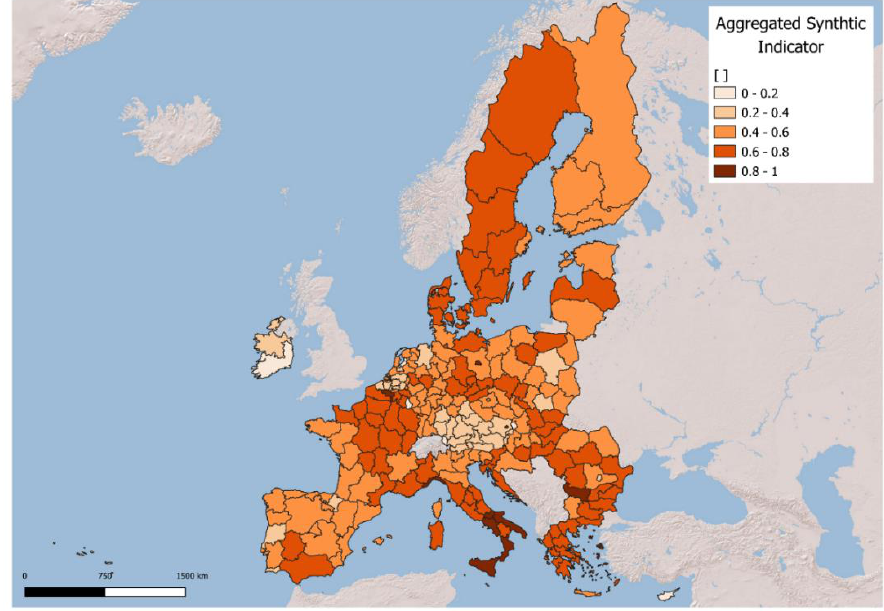
Figure 4. Aggregate indicator reflecting the regional criticality